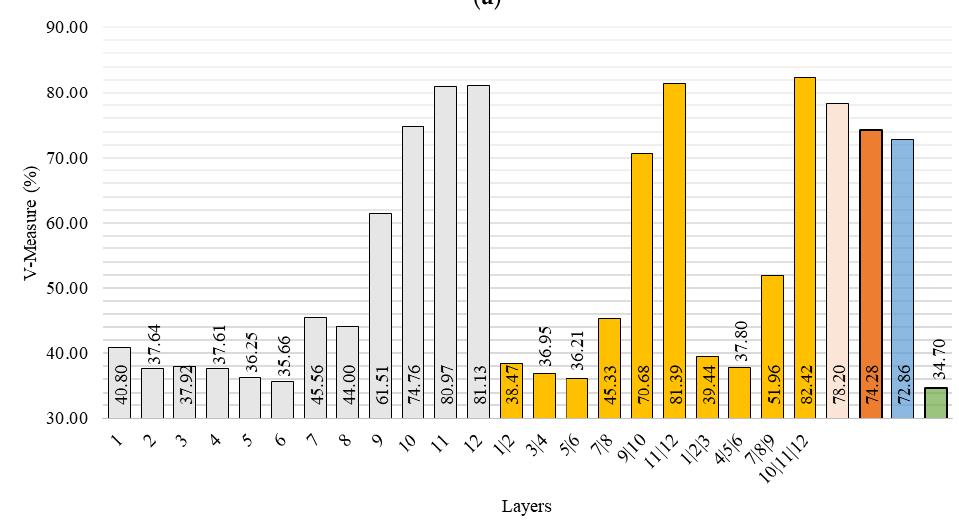
Figure 5. Mean V-measure score amongst the ( a ) SBERT and ( b ) SRoBERTa model layers, which were retrained in the Amazons-QA dataset, compared to their not-retrained versions and baseline